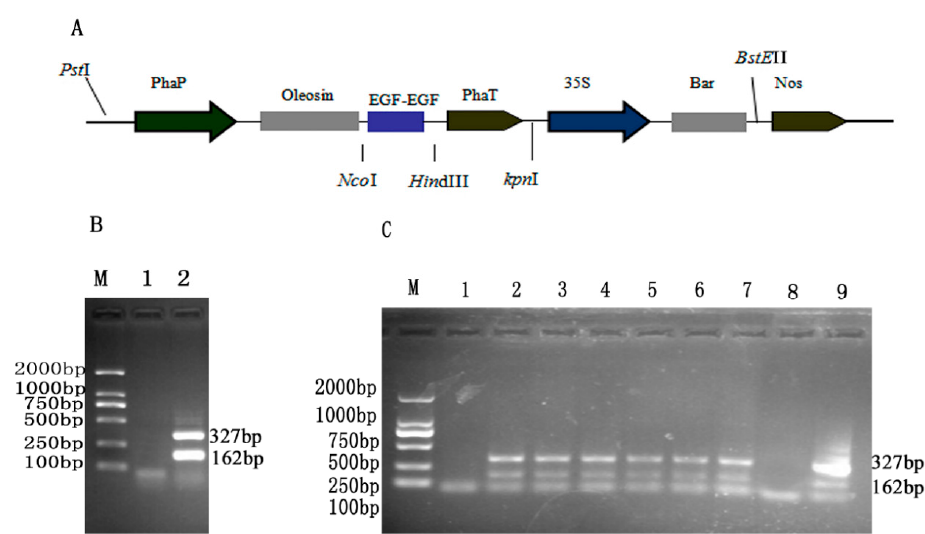
Figure 1. Construction and detection of pOTB–hEGF–hEGF. ( A ) Schematic diagram of T-DNA region from pOTB–hEGF–hEGF; ( B ) PCR detection of recombinant plasmid; ( C ) T3 transgenic Arabidopsis seeds were determined by RT–PCR; (M) DNA2000 marker; 1—negative control (wild type); 2–7—T3 transgenic seeds; 8—negative control (water); 9—positive control (pOTB–hEGF–hEGF plasmid).